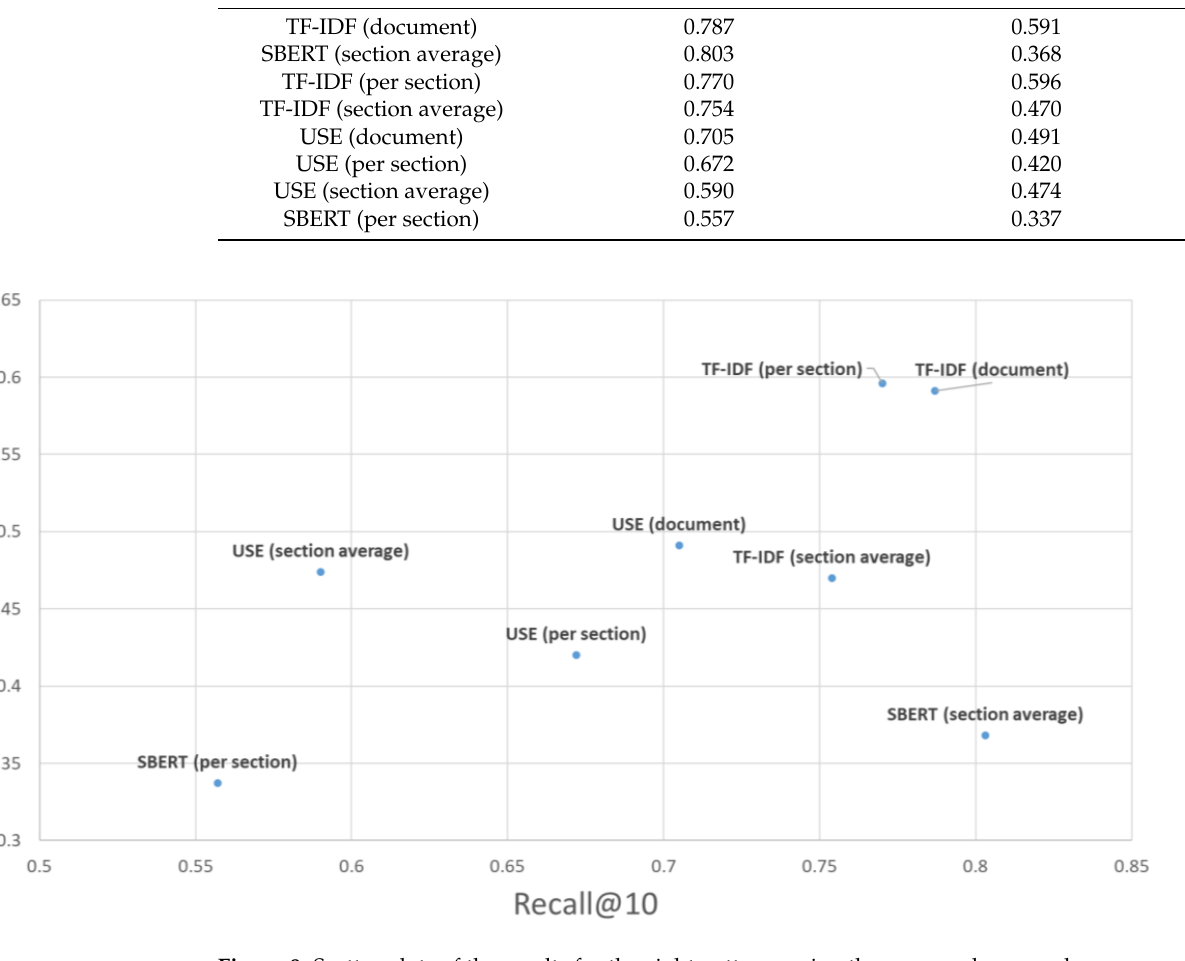
Figure 9. Changes in the percentage of CVE-ID linked to CWE-ID by year. Second, many CVE-IDs are linked to CWE-IDs with a high level of abstraction, such as CWE-20 and CWE-200. Figure 10 shows the frequency that highly abstract CWE-IDs are linked to each other. CWE-20 and CWE-200 are linked with high frequency. Highly abstract CWE-IDs generate two issues. First, the underlying weaknesses become invisible, and the chain and complex relationships are hidden. CWE-20 has the following descrip- tion: